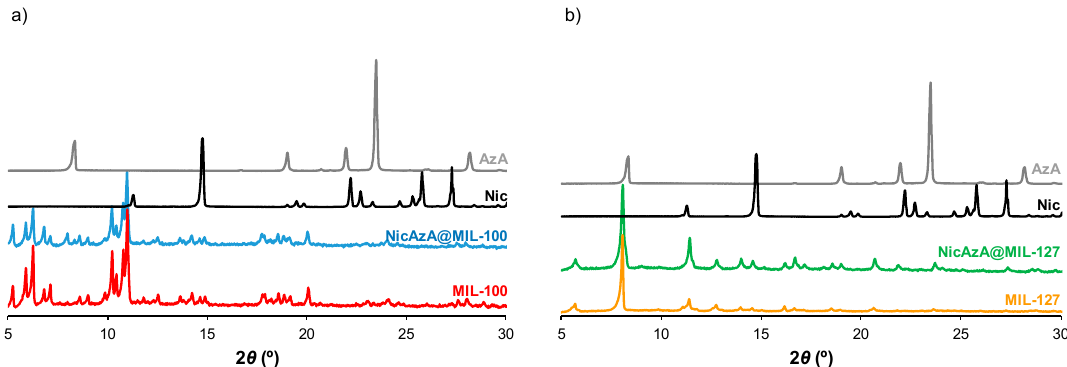
Figure 2. XRPD patterns of ( a ) MIL-100, NicAzA@MIL-100; and ( b ) MIL-127, NicAzA@MIL-127, as well as free Nic and AzA.